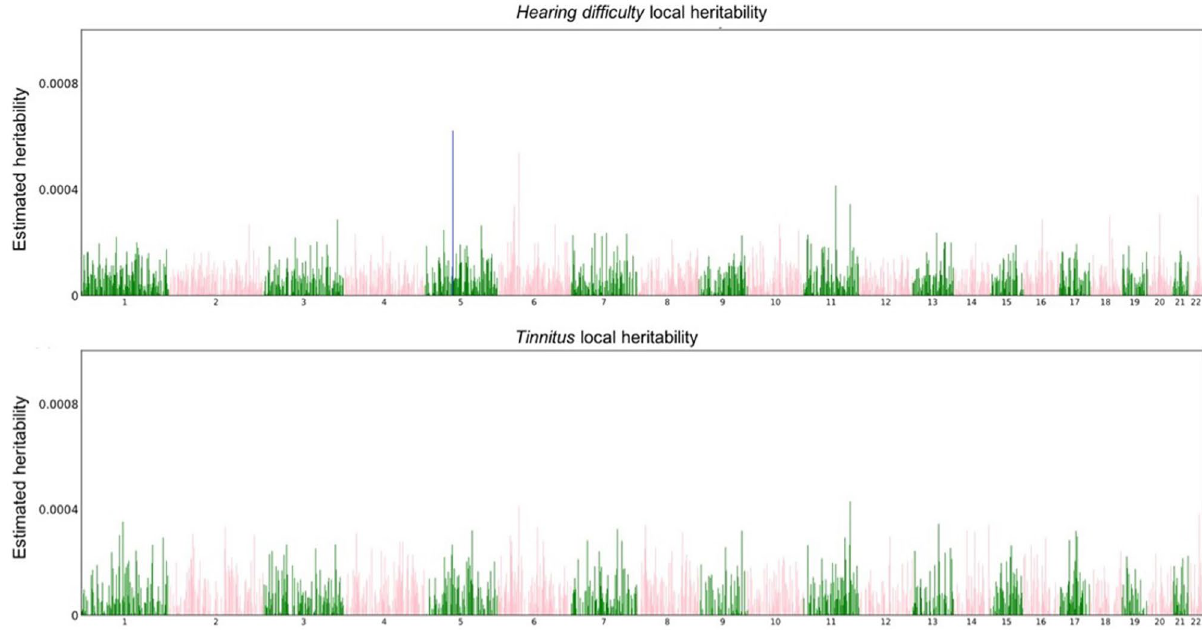
Figure 4. Manhattan-Style plots of regional heritability across the genome for hearing difficulty (top), and tinnitus (bottom). Estimated local SNP heritability for 1702 loci. Blue denotes an estimate of local_h2g = 0.0006, P < 1.157E−05 on Chr 5 for hearing difficulty in the region between base positions 71240456–73759326. HESS total SNP heritability estimates were 0.1, SE = 0.005 for hearing difficulty and 0.0853, SE = 0.013 for